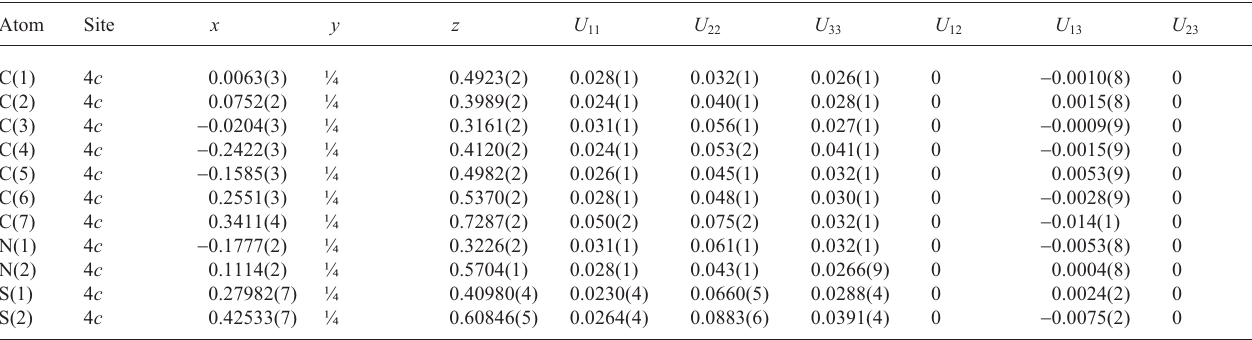
Table 3. Atomic coordinates and displacement parameters (in Å 2 )